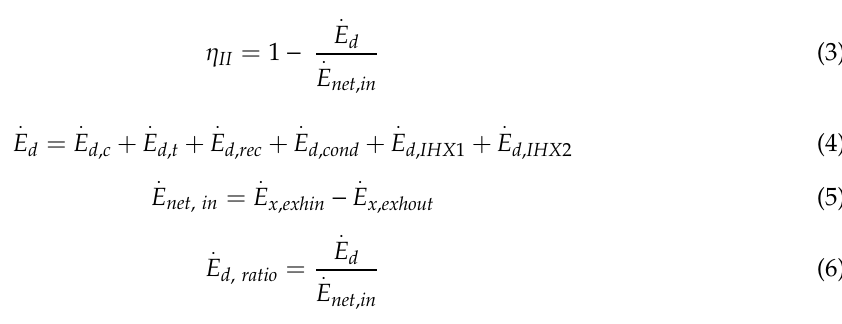
Table 3. Exergy balance rate equations for components of the sCO 2 bottoming power cycles. Adapted from